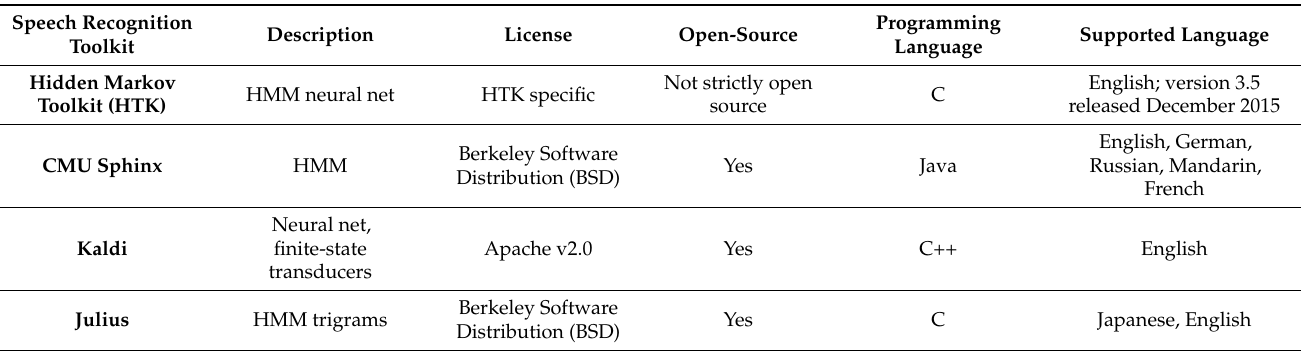
Table 1. Table 1. Open-source ASR